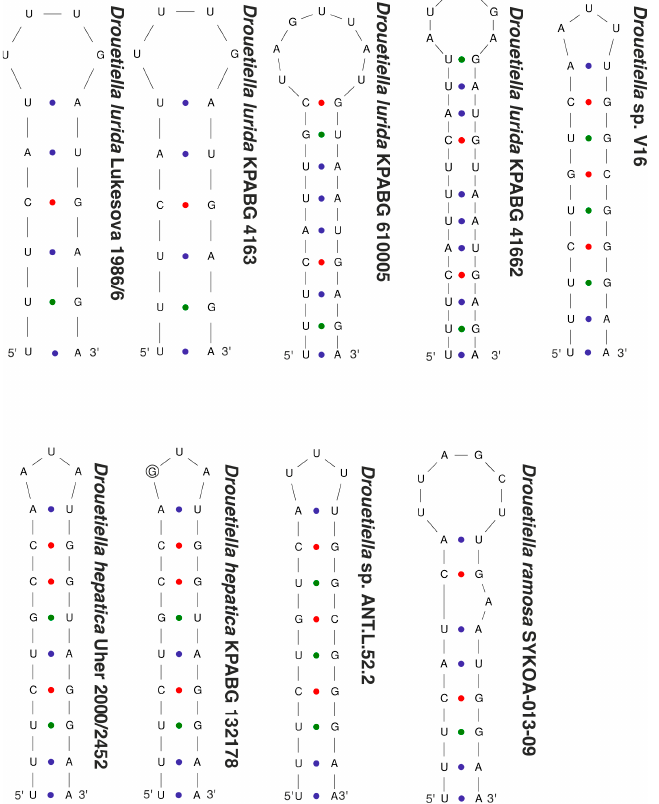
Figure 7. The secondary structure of the V2 helices of the 16S-23S ITS rRNA region of the Drouetiella strains. Circles indicate differences.